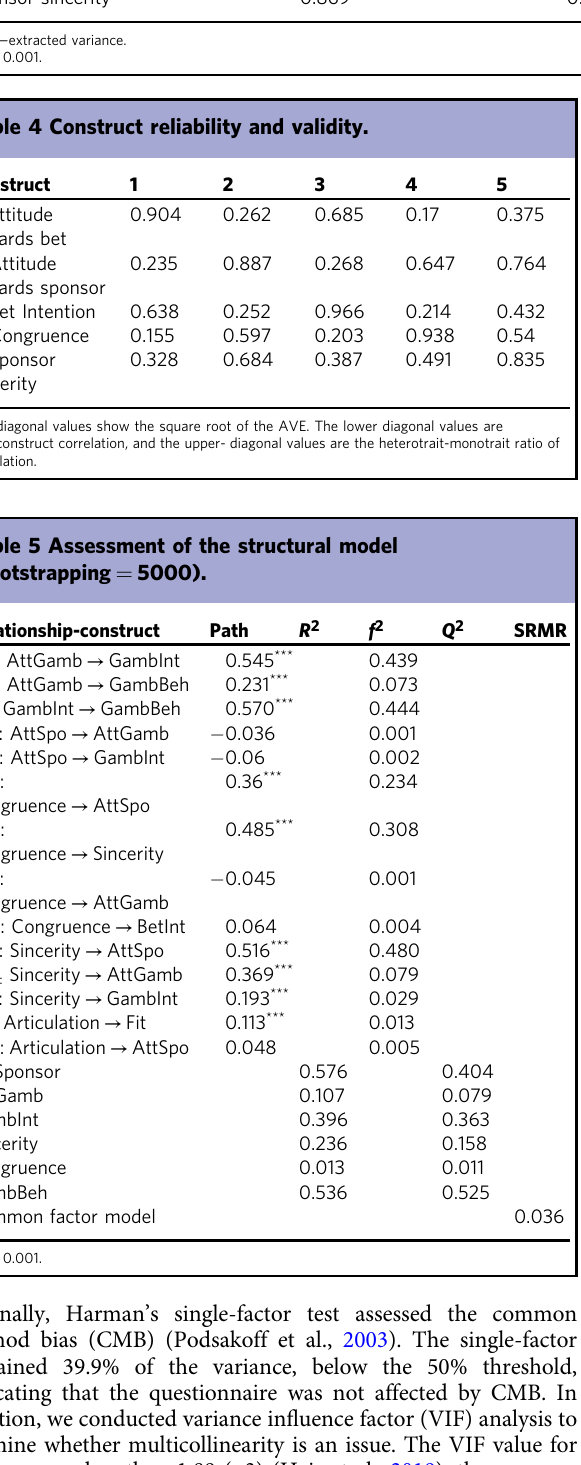
Table 4 Construct reliability and validity.